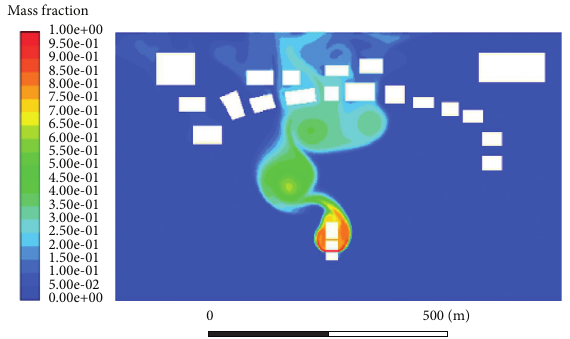
Figure 5: Radionuclide dispersion at the southern break.